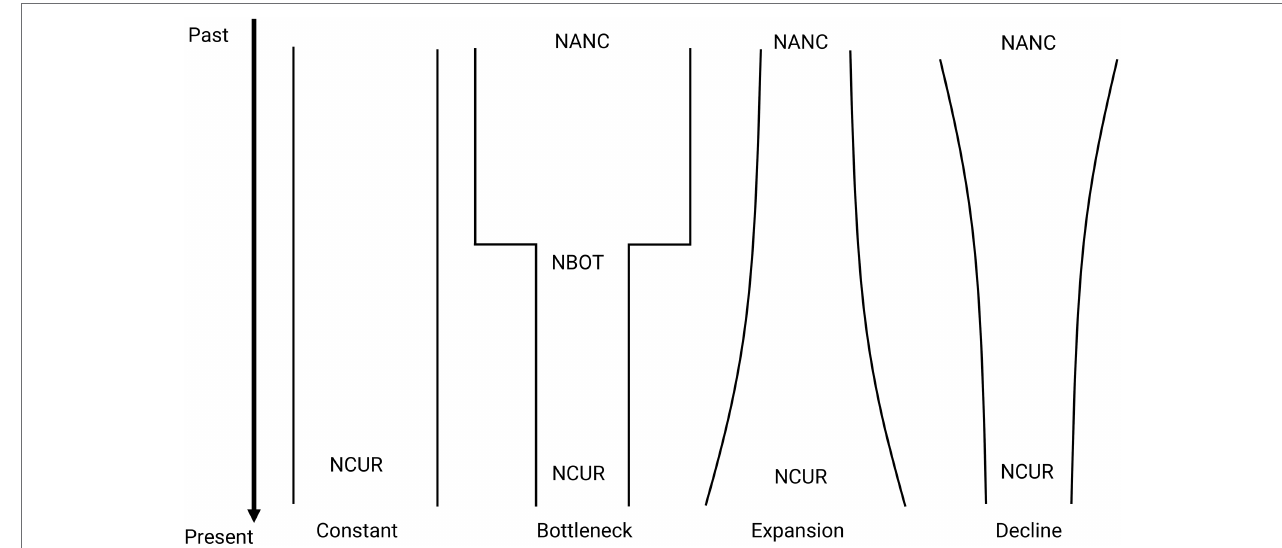
FIGURE 2 | Representation of the demographic scenarios tested for M. catharinensis in FastSimCoal 2.6. Estimates include coalescent-based current (NCUR) and ancestral (NANC) population size, number of generations since the bottleneck occurred (TBOT), and population size at the end of the bottleneck